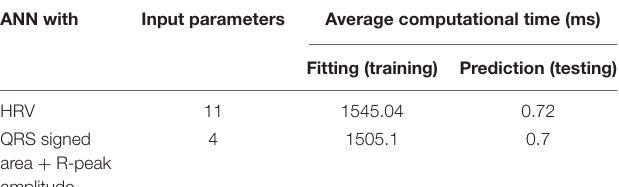
TABLE 4 | Computational time needed for training and testing ANN using 11 HRV and 4 QRS shape features.